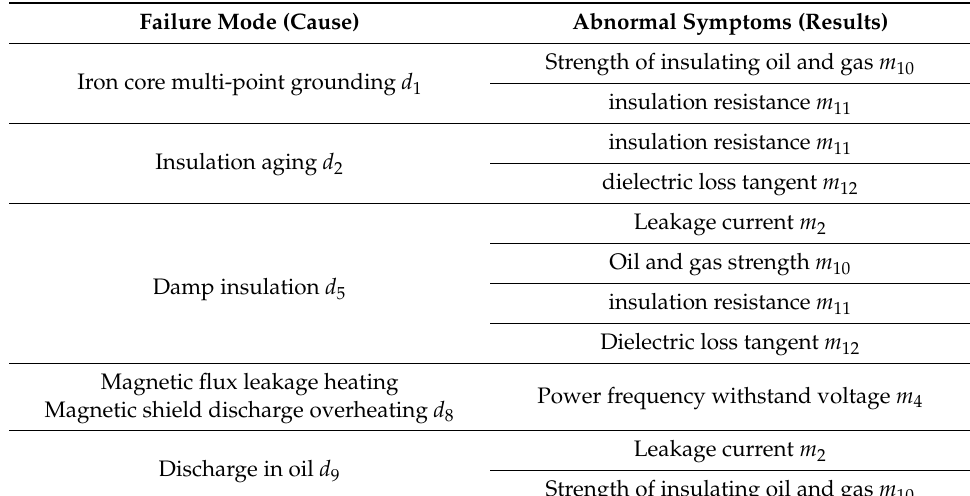
Table 5. Causal relationship between failure modes and abnormal symptoms.